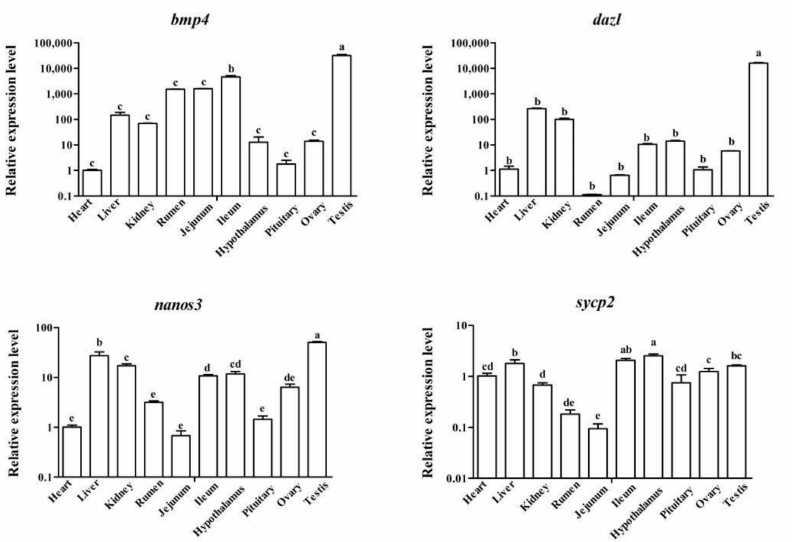
Figure 1. qPCR analysis of mRNA expression of bmp4 , dazl , nanos3 and sycp2 in different tissues of sheep. The expression of bmp4 , dazl , nanos3 and sycp2 in whole sheep tissues was analyzed using qPCR. The results were expressed relative to the heart tissue as mean values ± the SEM. Different letters represent significant differences between groups, p <